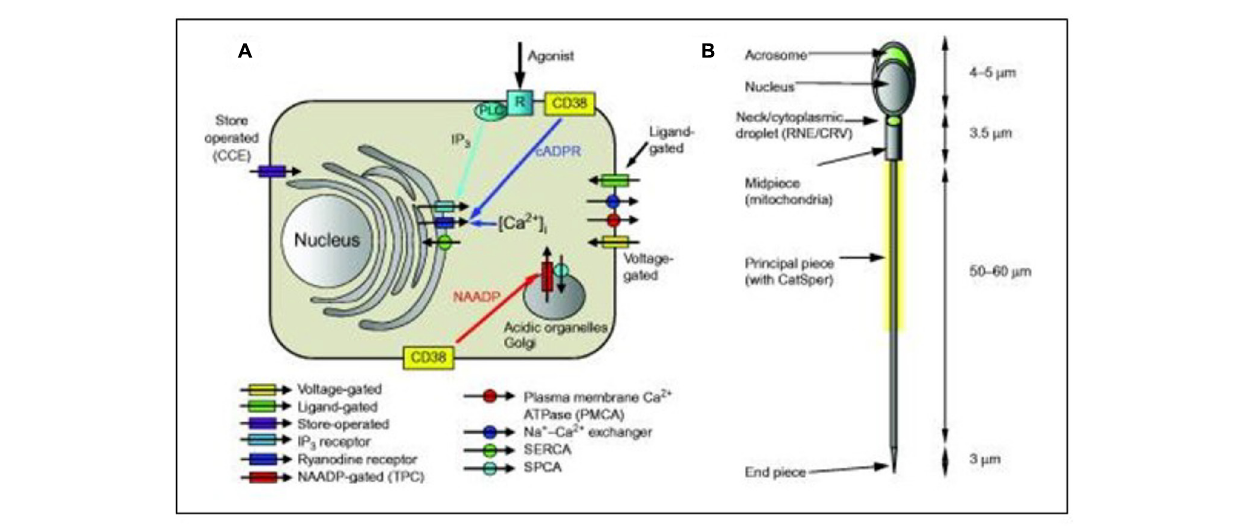
FIGURE 8 | Simplified diagrammatic summary of [Ca 2 + ] i signaling toolkit in a somatic cell. (A) Ion channels are shown as rectangles with arrow indicating normal direction of Ca 2 + flow (yellow, voltage-gated; green, ligand-gated; purple, store-operated; light blue, IP 3 receptor; dark blue, ryanodine receptor; red, NAADP-gated]. Pumps are shown as circles with arrows indicating normal direction of Ca 2 + movement (red, PMCA; blue, Na + –Ca 2 + exchanger; green, SERCA; blue, SPCA). Activation of IP3 receptors by membrane receptor activation and phospholipase C is shown in light blue. Generation of cADPR and NAADP by CD38 and possibly other enzymes (leading to mobilization of Ca 2 + from intracellular stores) is shown by yellow boxes. (B) Structure of human sperm showing positions of CatSper channels (yellow shading around anterior flagellum) and Ca 2 + stores in the acrosome and at the sperm neck (redundant nuclear envelope and calreticulin-containing vesicles) (shown in green). From Correia J, Michelangeli F, Publicover S., 2015 Regulation and roles of Ca 2 + stores in human sperm. Reproduction 150, R65-R76. With thanks for the